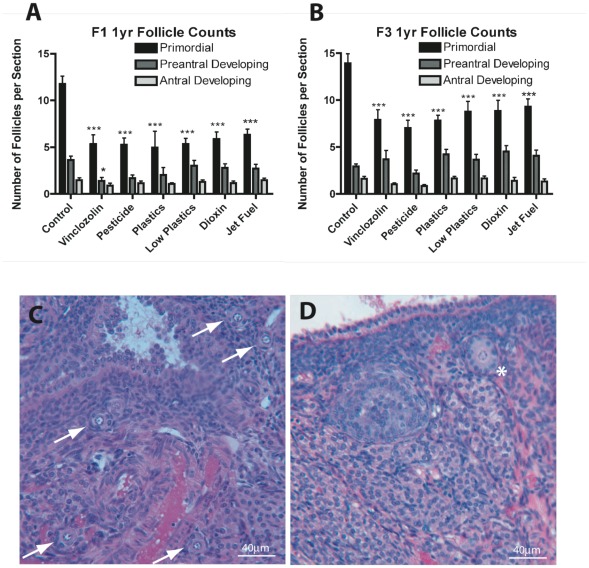
Follicle numbers and development.A) Number of primordial, preantral, and antral follicles per section in F1 generation ovaries. N = 9 animals per treatment group. B) Number of follicles per section in F3 generation ovaries. N = 9 animals per treatment group. Asterisks indicate groups significantly (*p≤0.05, ***p≤0.005) different than controls of their own follicle type by ANOVA followed by Dunnet's post-hoc test. C) H and E stained section of F3 generation control ovary showing several primordial follicles (arrows). D) H and E stained section of F3 generation vinclozolin lineage ovary without visible primordial follicles. Asterisk indicates a developing secondary follicle. Scale bar = 40 µm.